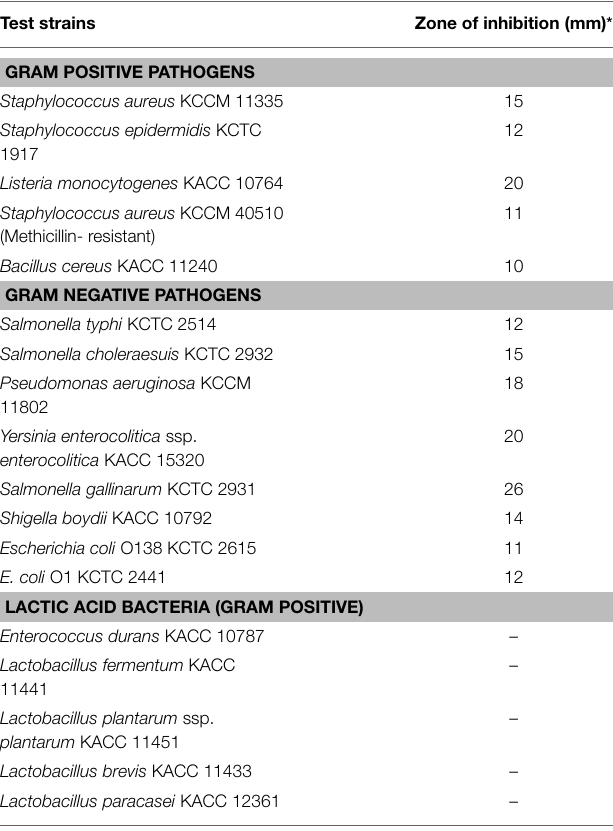
TABLE 3 | Antimicrobial activity of culture filtrate of strain KID7. Test strains Zone of inhibition (mm)